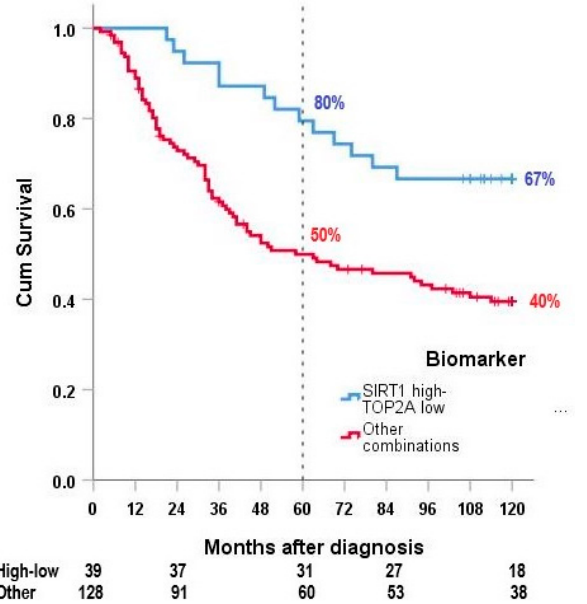
Figure 5. Overall survival with favorable “Top Survivor” biomarker expression (high SIRT1, low TOP2A) compared to other biomarker combinations.